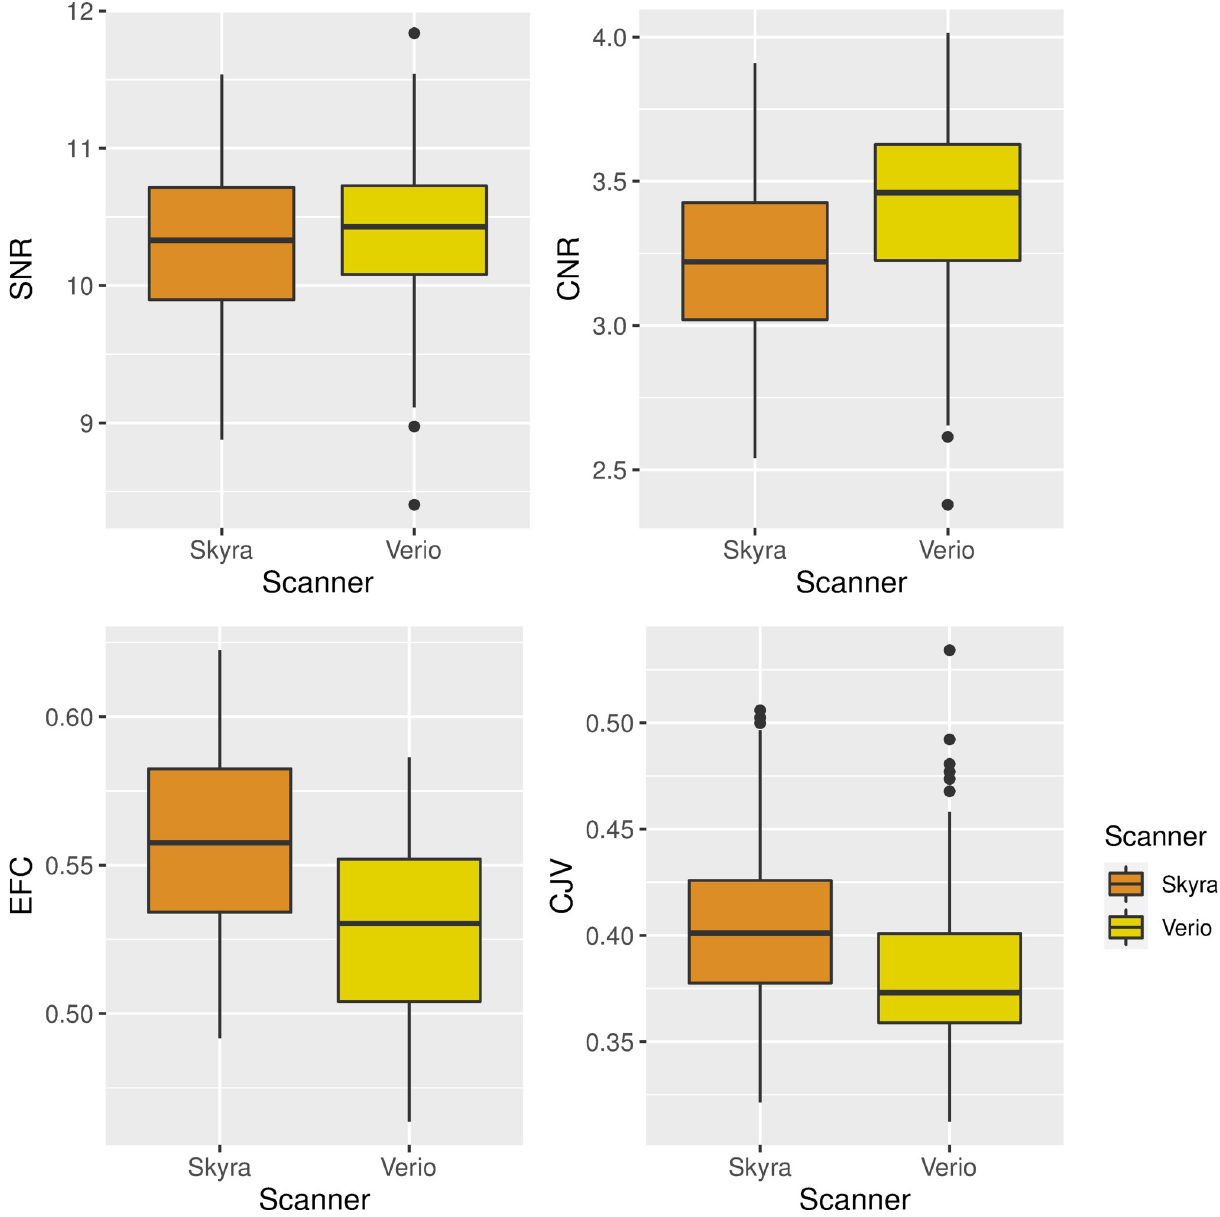
Fig 8. Quality metrics (SNR and CNR (left/right in upper row), EFC and CJV (left/right in bottom row)) compared between Skyra ND (orange) and Verio ND (yellow) acquisitions, showing overall higher data quality on the Verio